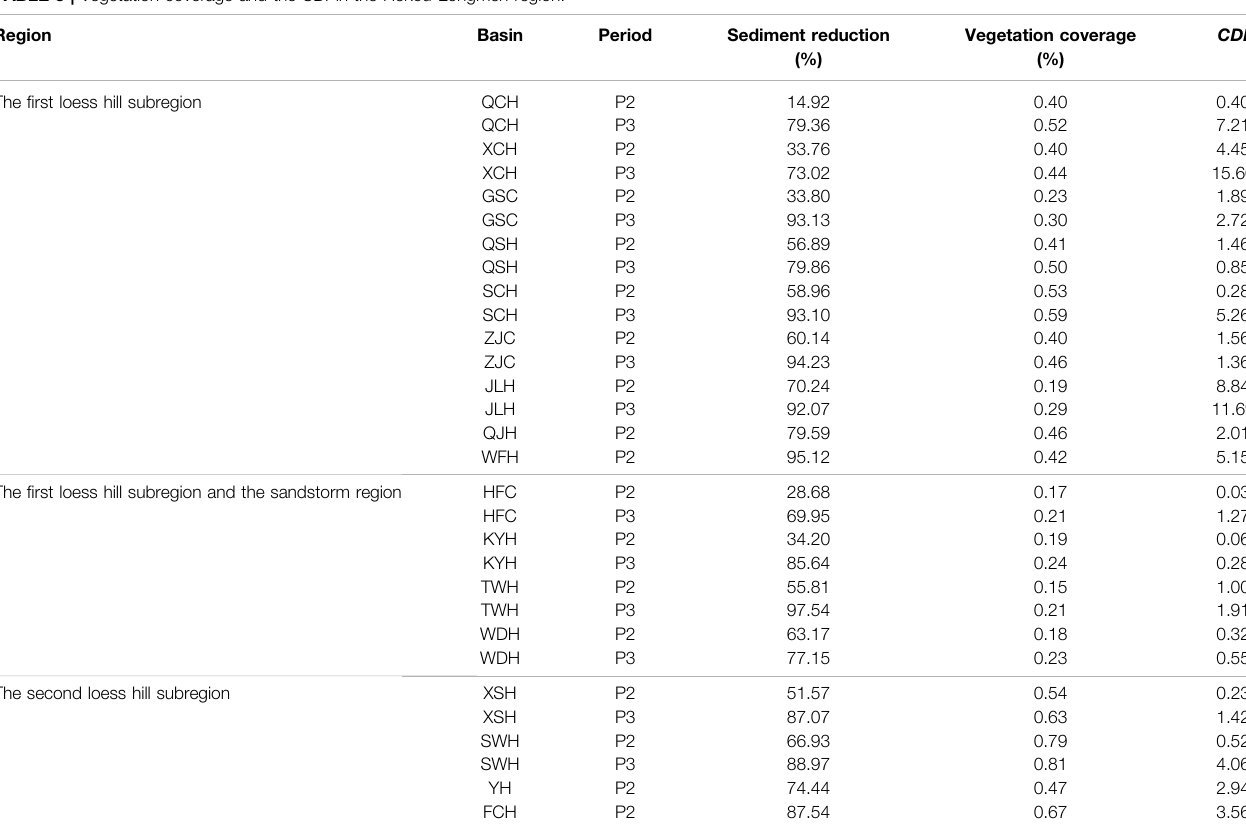
TABLE 3 | Vegetation coverage and the CDI in the Hekou-Longmen region. Region Basin